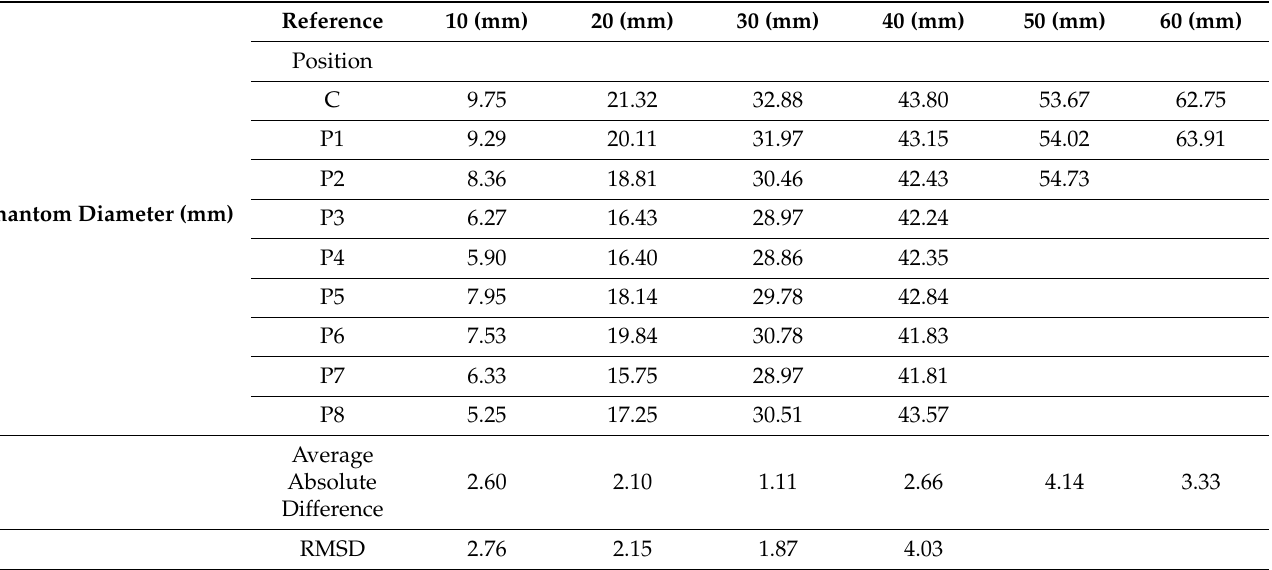
Table 2. Diameter obtained for different concentric and eccentric